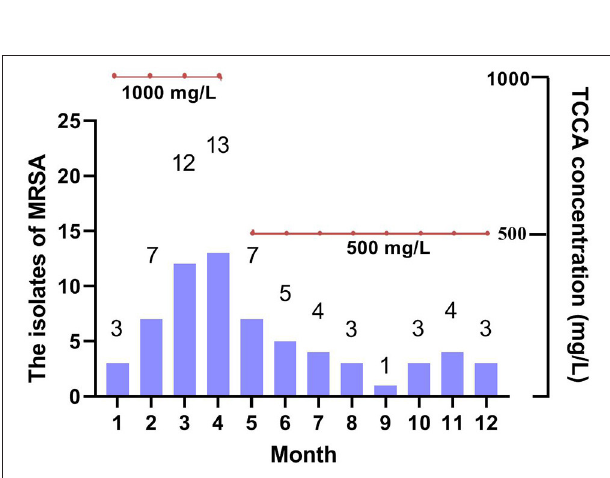
FIGURE 3 | The isolates of MRSA and the concentration of disinfectant in